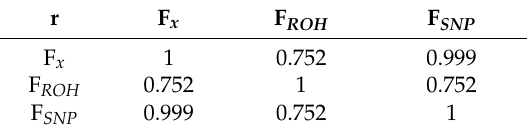
Table 5. Correlations between the different methods of inbreeding